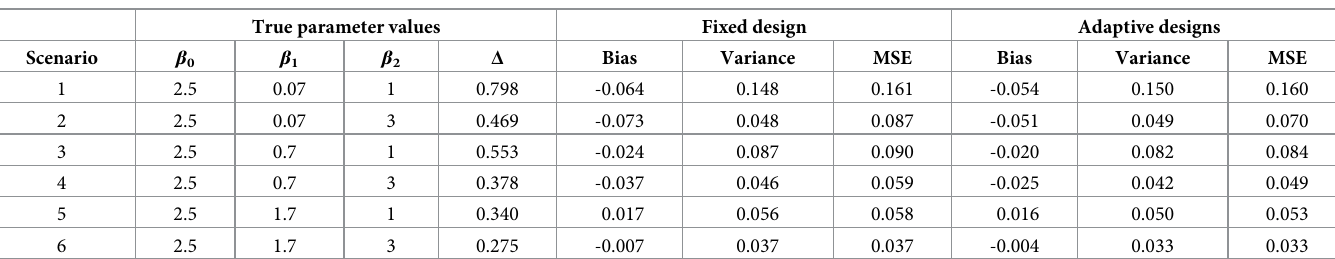
Table 2. Simulation